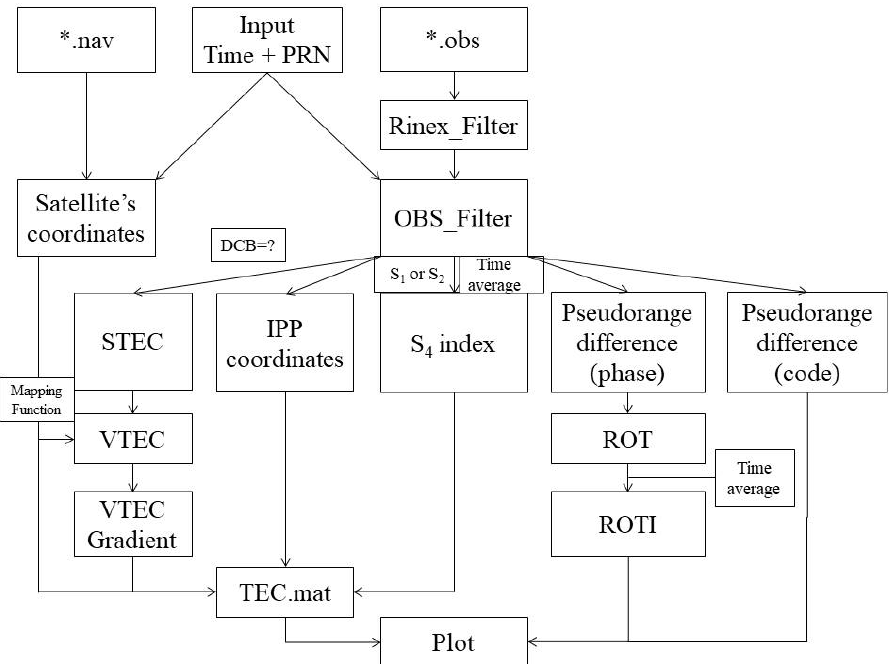
Figure 3. Flowchart of the ionosphere software tool. The input data are the observation and navigation files of the RINEX data. The output results include certain ionospheric parameters with the aim of detecting disturbances in the ionosphere that affect the GNSS measurements.